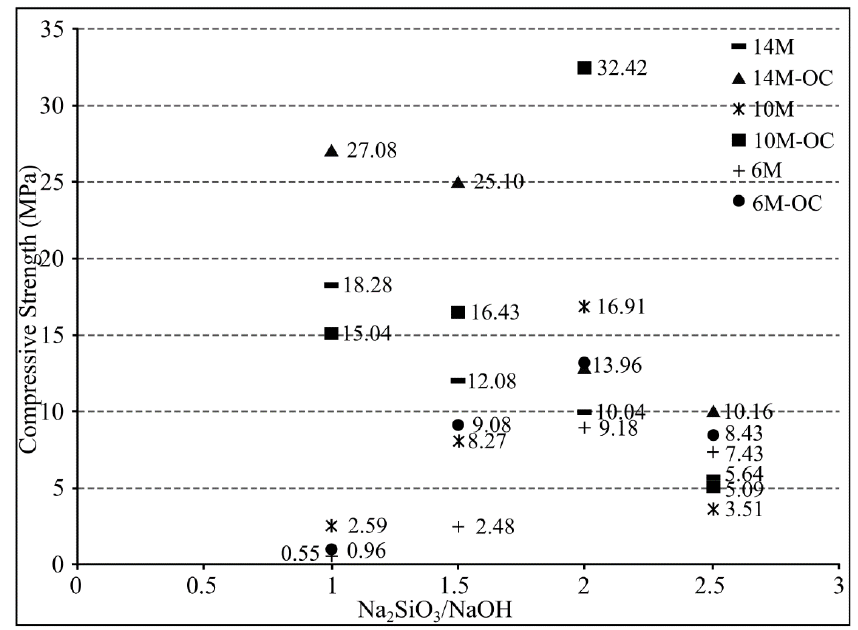
Figure 10. Compressive strengths of alkali-activated fly ash/slag specimens based on alkaline acti- vator ratio type [139]. activator ratio type